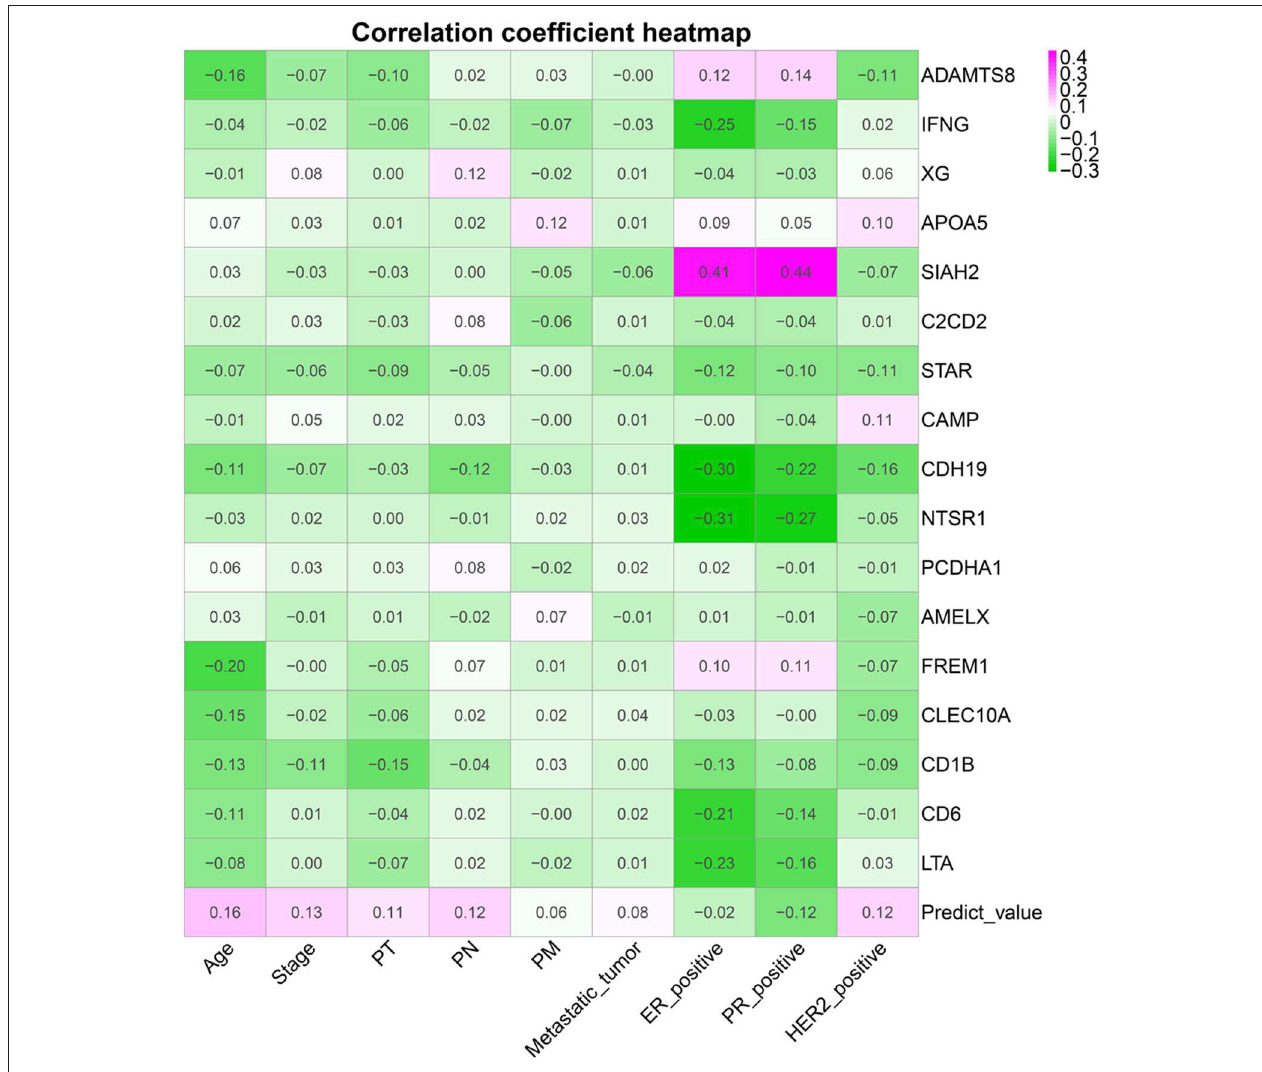
FIGURE 9 | Clinical variable correlation coefficient